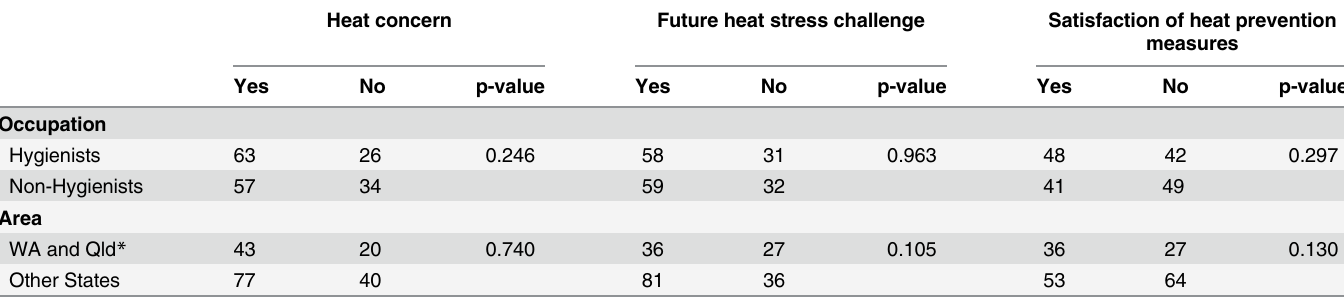
Table 3. Comparison of heat concern, attitudes toward climate change related heat challenge, and satisfaction level of heat prevention measures by occupation and area (Chi-square